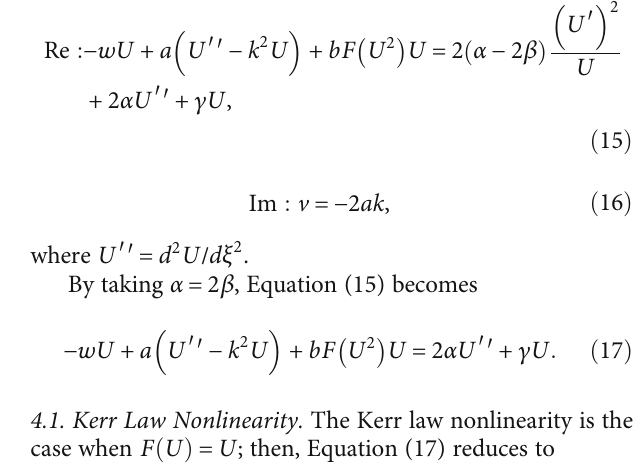
p 4 AC − 4 C − B 2 4 AC − 4 C − B 2